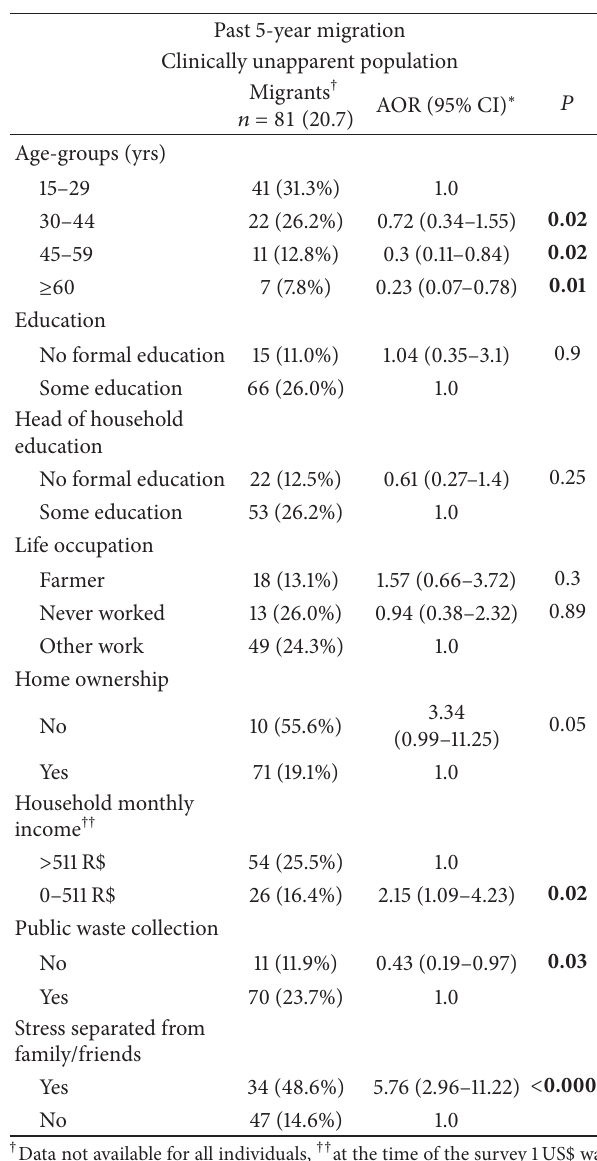
Table 4: Multivariate analysis of factors associated with past 5 year migration among migrants in a clinically unapparent population without symptoms of leprosy compared to clinically unapparent non-migrant